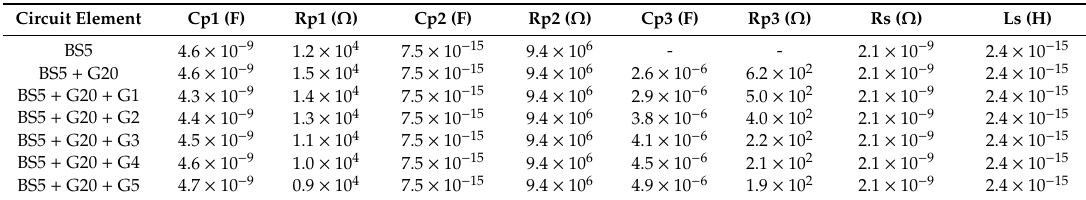
Table A3. Modeled impedance parameters Cp1, Rp1, Cp2, Rp2, Cp3, Rp3, Rs, and Ls of biochip BS5, with 10%